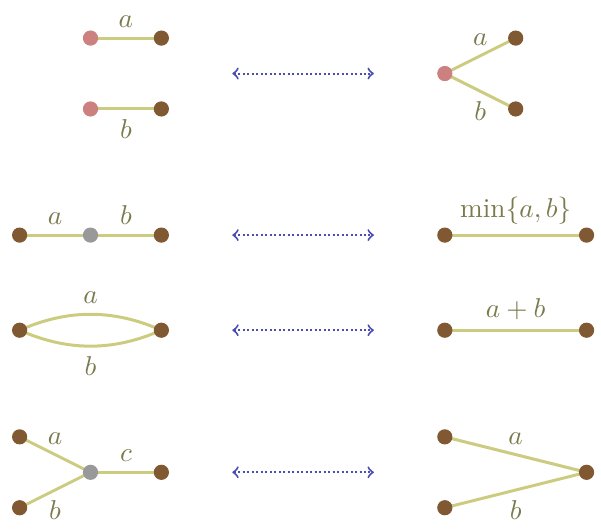
Figure 16. Basic entropy-preserving graph operations. The last one requires c ≥ a + b . Brown vertices are to be kept fixed under these operations. Boundary vertices are colored in red, and bulk ones in gray. In a general graph, both brown and red vertices may connect to arbitrarily many other edges, whereas gray ones should only appear as shown.